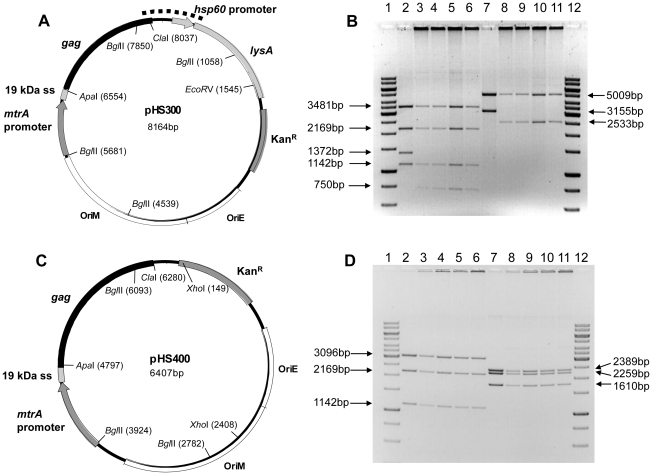
Schematic maps and restriction enzyme digests of pHS300 and pHS400 plasmid DNA isolated from rBCG.(A) Schematic map of plasmid pHS300. The deleted region, found in plasmid DNA isolated from vaccine stocks of rBCG, is indicated by a thick, dotted line. (B) Lanes 2 & 7 contain plasmid DNA prepared prior to transformation into BCG (positive controls). Lanes 3–6 and 8–11 contain pHS300 plasmid DNA isolated from 4 different rBCG[pHS300] transformants. Plasmid DNA in lanes 2–6 was digested with restriction enzyme BglII and plasmid DNA in lanes 7–11 was digested with restriction enzymes EcoRV & ApaI. (C) Schematic map of plasmid pHS400. (D) Lanes 2 & 7 contain pHS400 plasmid DNA prepared prior to transformation into BCG (positive controls). Lanes 3–6 and 8–11 contain plasmid DNA isolated from 4 different rBCG[pHS400] (rBCG-Gag) transformants. Plasmid DNA in lanes 2–6 was digested with restriction enzyme BglII and plasmid DNA in lanes 7–11 was digested with restriction enzymes XhoI & ApaI. Results were the same for rBCG and rBCGΔpanCD.